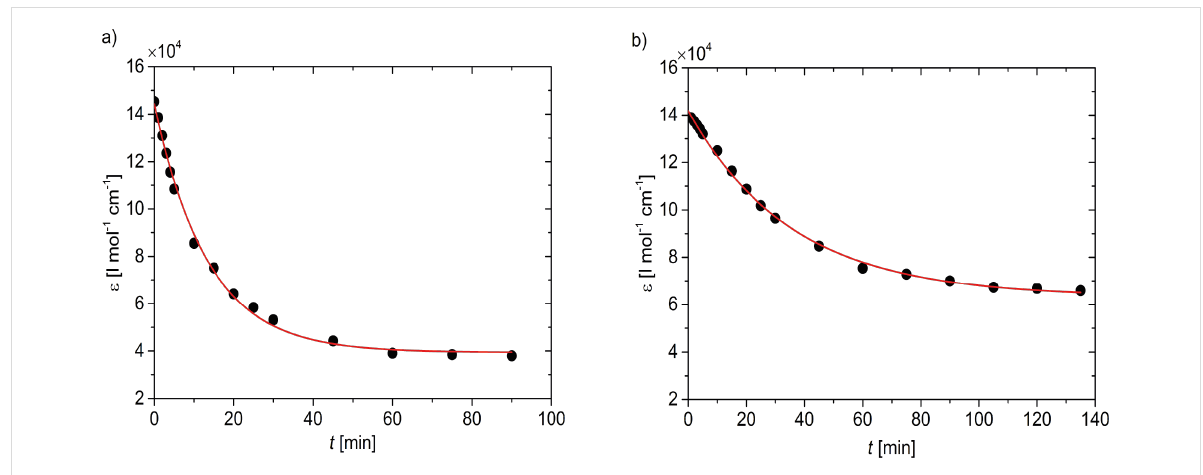
Figure 3: Continuous illumination of the trimer 1 in dichloromethane solution by UV light of 254 nm (a) and 365 nm (b). The exponential decay (red line) of the molar extinction coefficient illustrates the phototriggered dissociation of the parent structure.